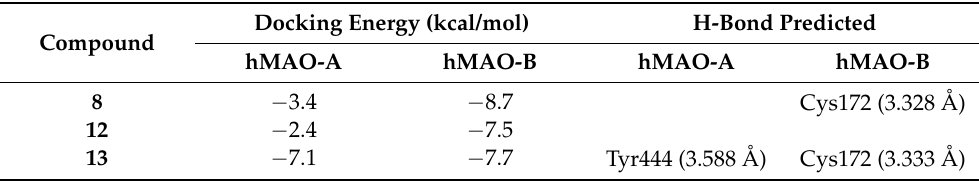
Table 3. Docking scores and predicted hydrogen bond(s) of the three compounds with hMAO-A or hMAO-B